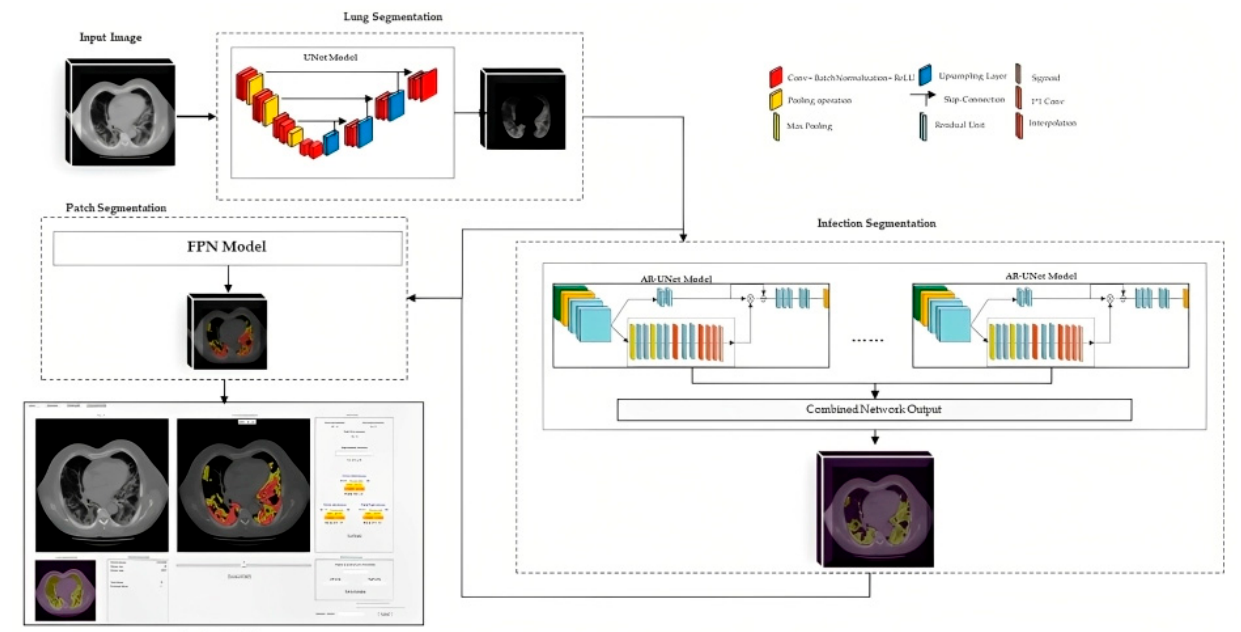
Figure 5. The flowchart of the proposed method.